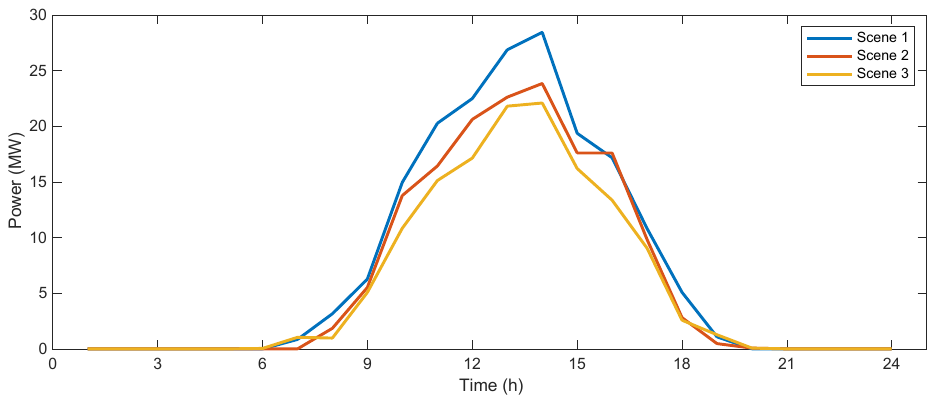
Figure 5. Scene reduction of PV output.